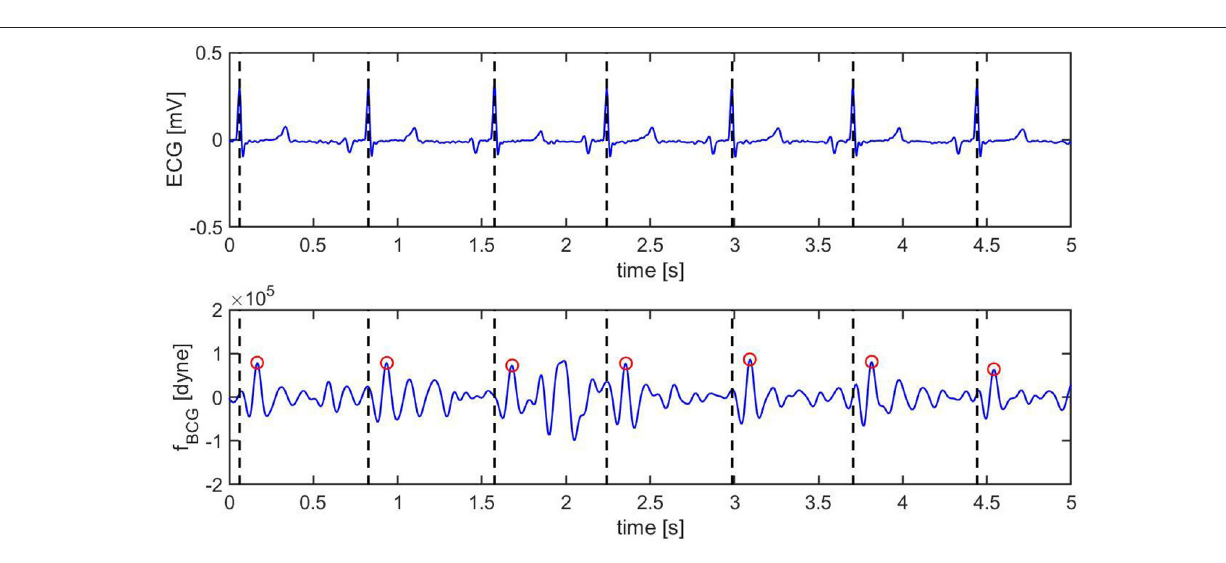
FIGURE 8 | Ten s sample of ECG (top) and BCG (bottom) signals recorded synchronously in swine before inducing myocardial infarction (Subject A2). The vertical black dashed lines mark the R peaks in the ECG. The red circles mark the J peak in the